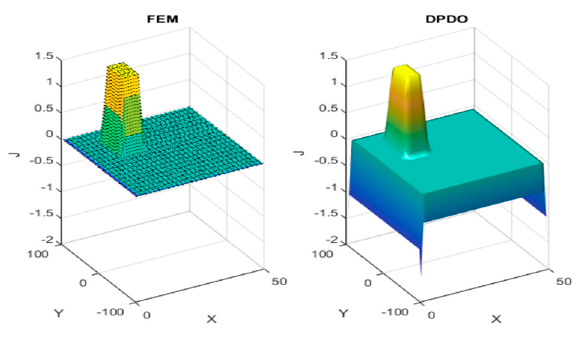
( , ) j x y for d / dx 2 y = . Figure 8. Ampere-turn function j 1 ( x , y ) and the modified excitation j mod ( x , y ) for d y /dx = mod